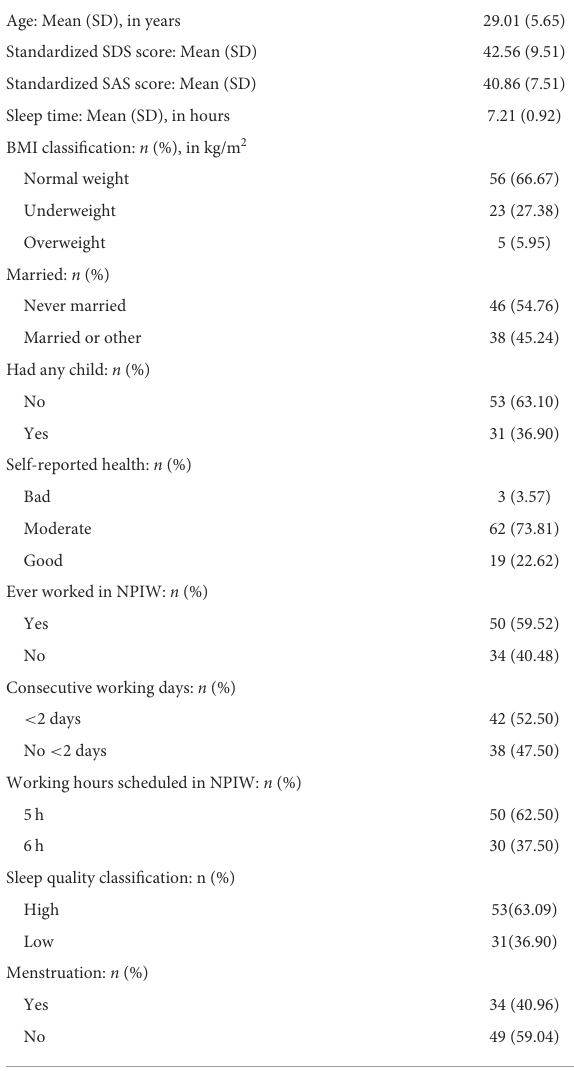
TABLE 1 Description of baseline characteristics for the 84 included nurses working in NPIW. Variables